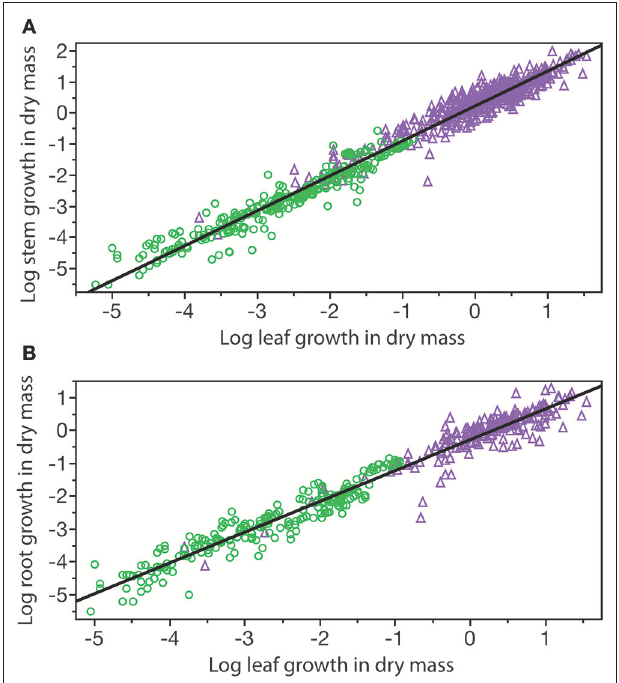
FIGURE 6 | Bivariate plots of log 10 -transformed data for stem, leaf, and root annual growth rates (original units stranding dry mass produced per year per plant) for herbaceous non-woody (green circles) and woody (purple triangles) species. Solid lines are log-log regression curves. (A) Stem growth vs. leaf growth. (B) Root growth vs. leaf growth. See text and Table 1 for scaling formulas and regression parameters. Data for herbaceous species taken from the primary botanical literature; data for woody species taken from the Cannell (1982) worldwide compendium.